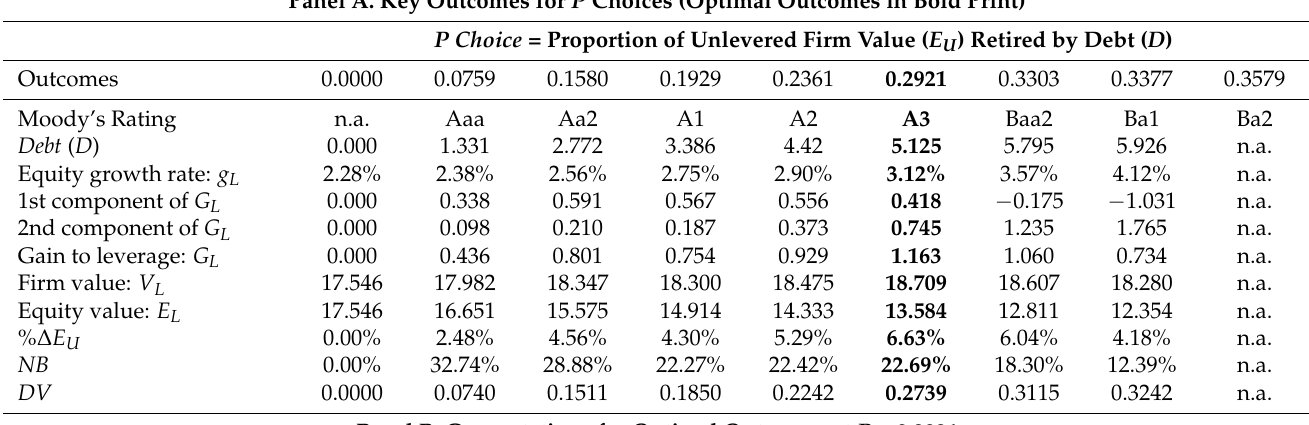
Table 3. Nonprofit Illustration.